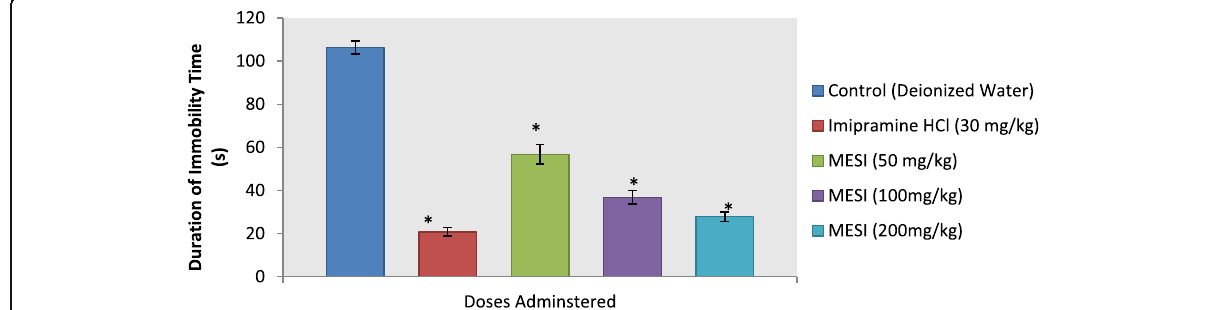
Fig. 2 Graphical presentation of the effect of MESI on immobility time in FST